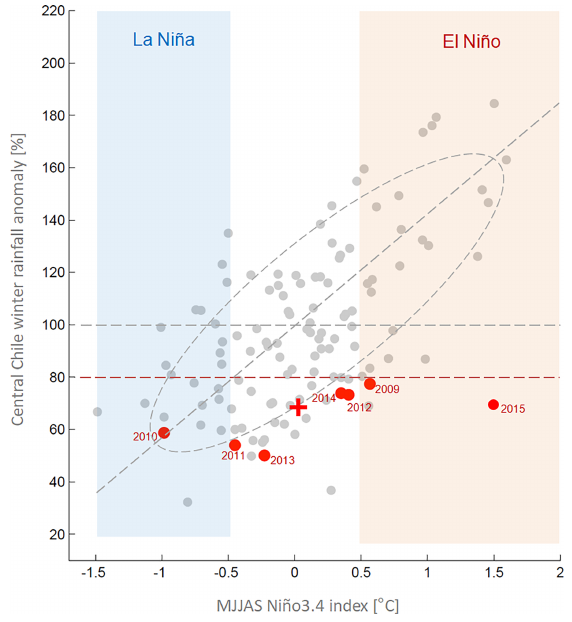
Figure 8. Scatter plot between the winter (MJJAS) average of Niño3.4 and the central Chile precipitation index (RPI). Data from 1915 onwards; the years forming the MD are highlighted in red. The Niño3.4 index is the area-averaged SST anomaly in the region 5 ◦ S–5 ◦ N and 170–120 ◦